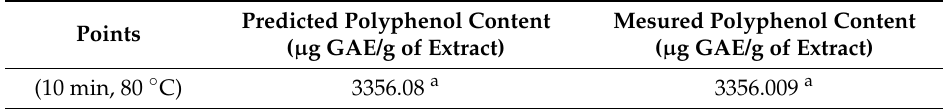
Table 4. Confirmation results of the model with the measured values and the predicted values of the studied responses.